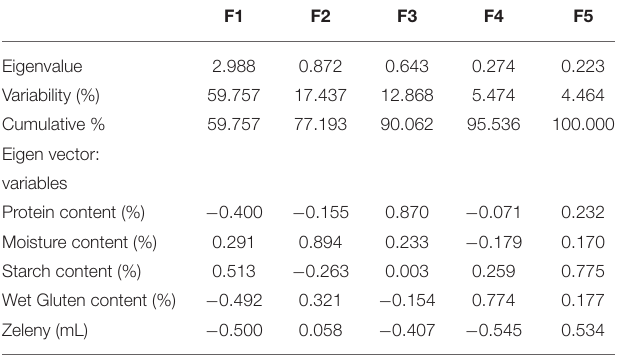
TABLE 10 | Principal component analysis for different quality parameters regarding grain nutritional profile in wheat